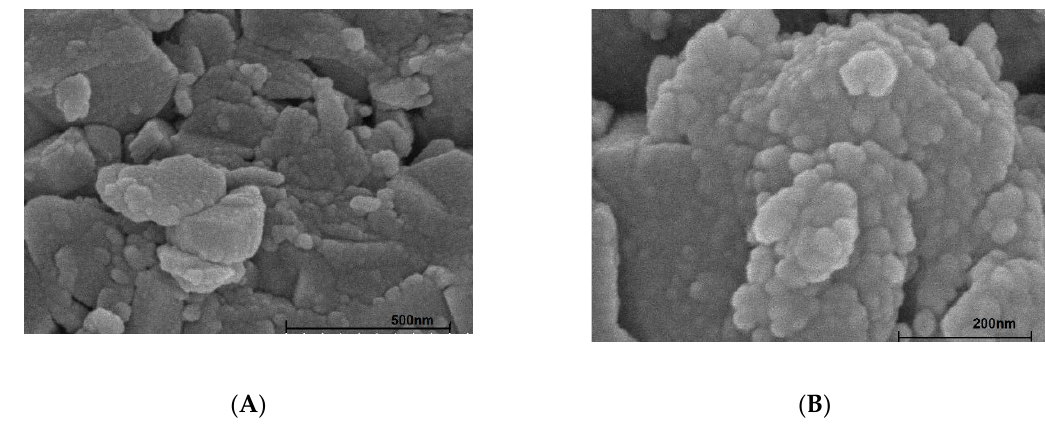
Figure 4. SEM images of nano-aluminum hydroxide with different scales: 500 nm ( A ) and 200 nm ( B ).